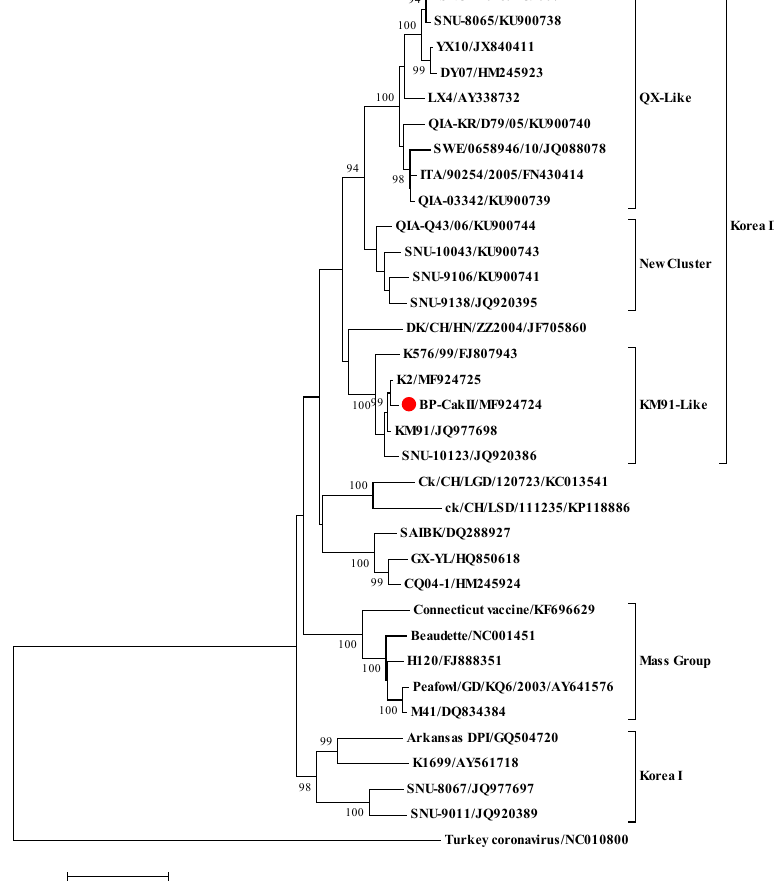
Figure 3. Phylogenetic analysis of the S1 genes of infectious bronchitis viruses. Phylogenetic trees are based on the S1 amino acid sequence of IBVs, where the BP-caKII strain is marked with a red filled circle. Phylogenetic trees were constructed with the neighbor-joining method using MEGA 6.0. The bootstrap values were determined from 500 replicates of the original data. The branch number represents the percentage of times that the branch appeared in the tree. Bootstrap values greater than 50% are shown. The p-distance is indicated by the bar at the bottom of the figure.